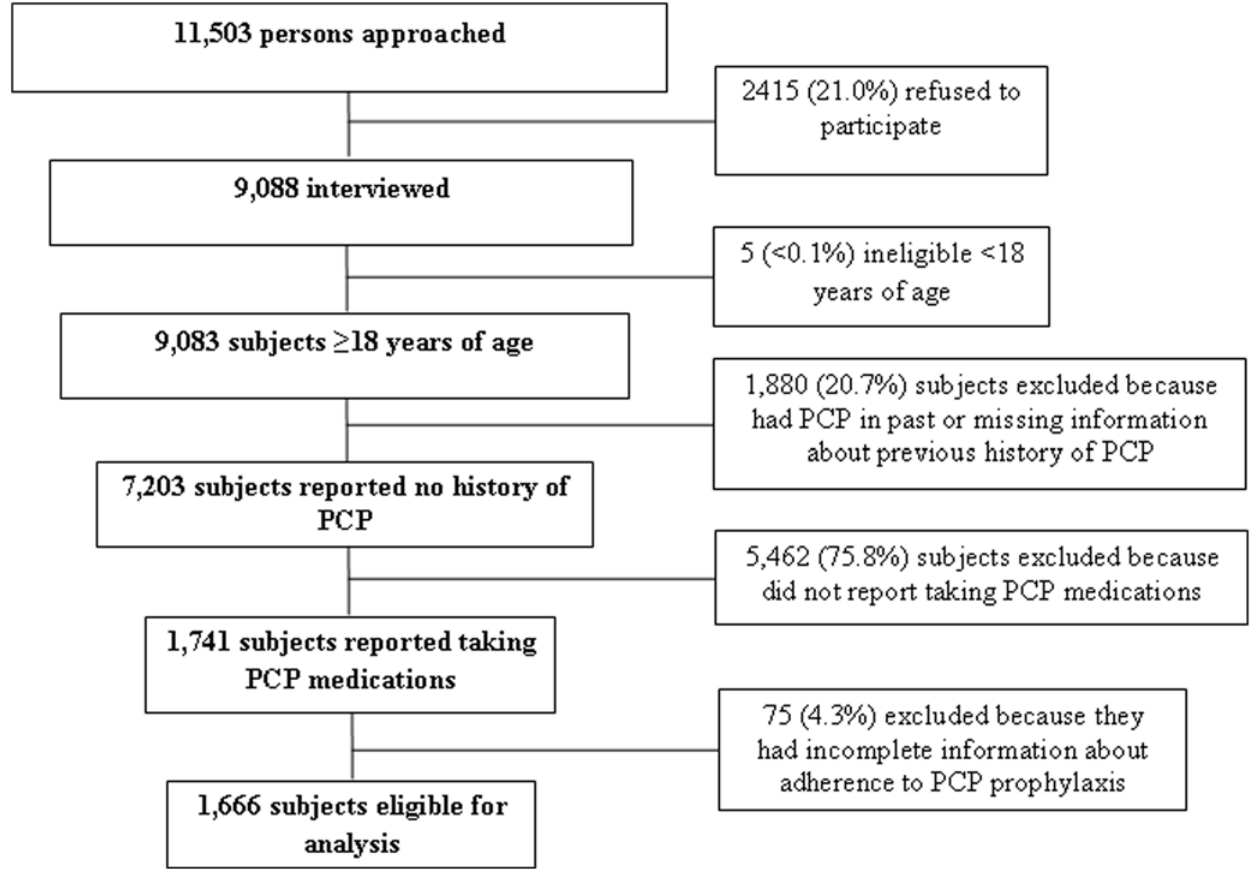
Figure 1. Eligibility and selection criteria for subjects included in this analysis of nonadherence to Pneumocystisjirovecii pneumonia (PCP) prophylaxis – Supplement to HIV/AIDS Surveillance (SHAS) project, 2000–2004.